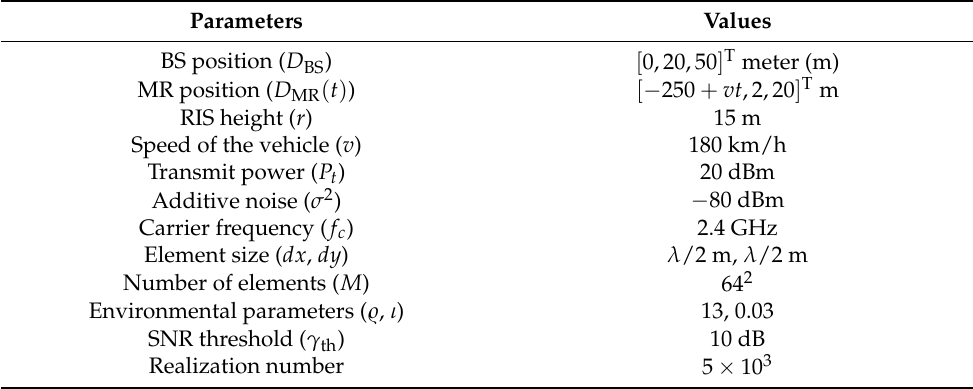
Table 2. Simulation parameters